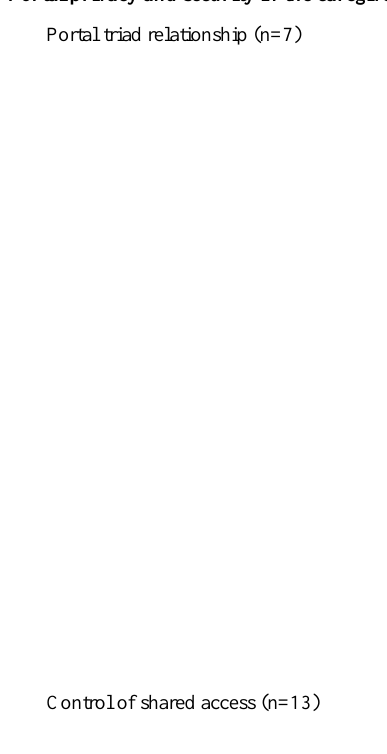
Table 3. Themes and subthemes on challenges to portal use with exemplar quotes. QuotesThemes/subthemes Portal privacy and security in the caregiver-provider-patient triad (n=38) Portal triad relationship